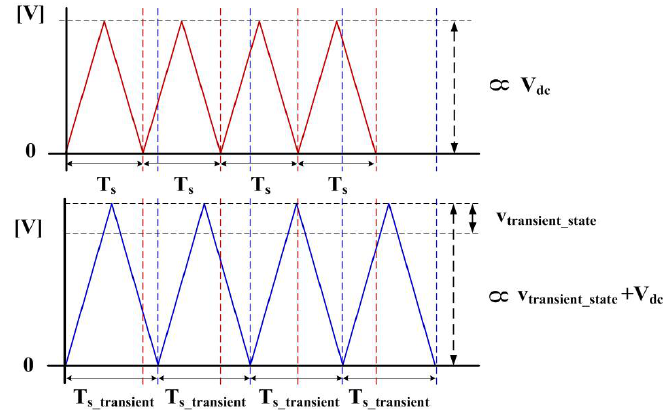
Figure 5. The relation between switching frequency and carrier wave in micro controller unit (MCU).